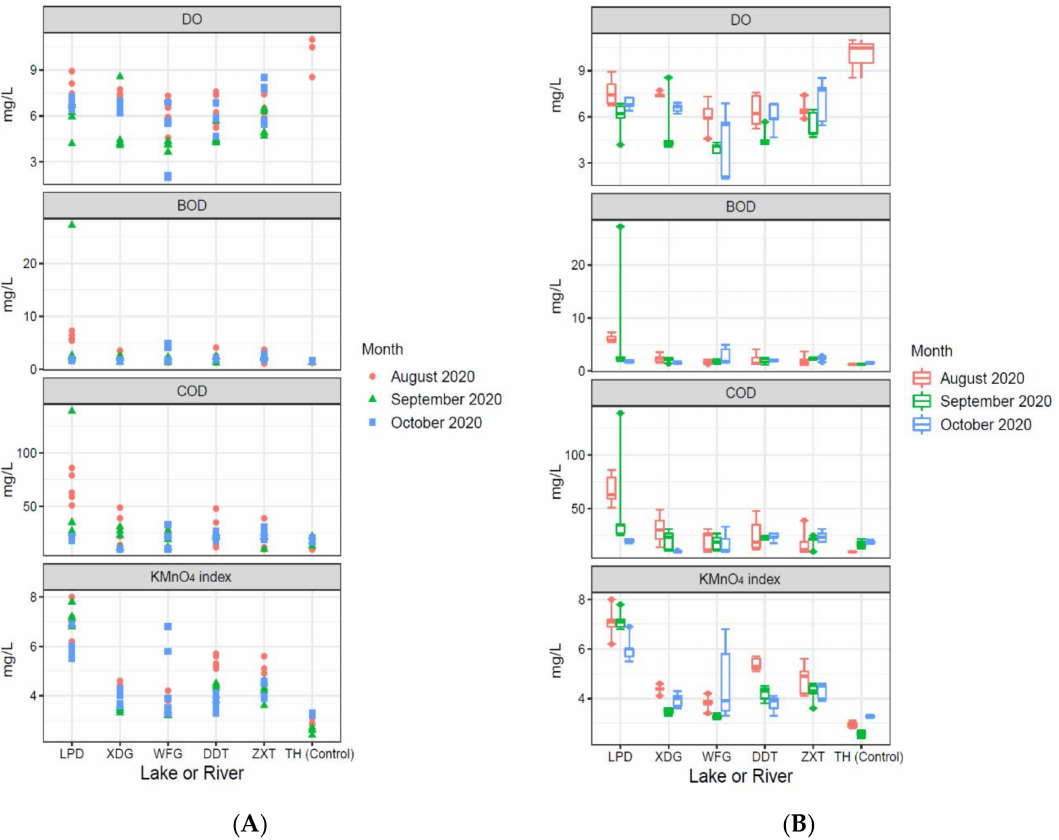
Figure 2. The variation in dissolved oxygen (DO), biochemical oxygen demand (BOD), chemical oxygen demand (COD), and potassium permanganate (KMnO 4 ) values observed in different sampling locations and months. The individual value for each parameter ( A ) and boxplots ( B ) with minimum and maximum values (whiskers), median value (line within each box), and quartile interval (box) are